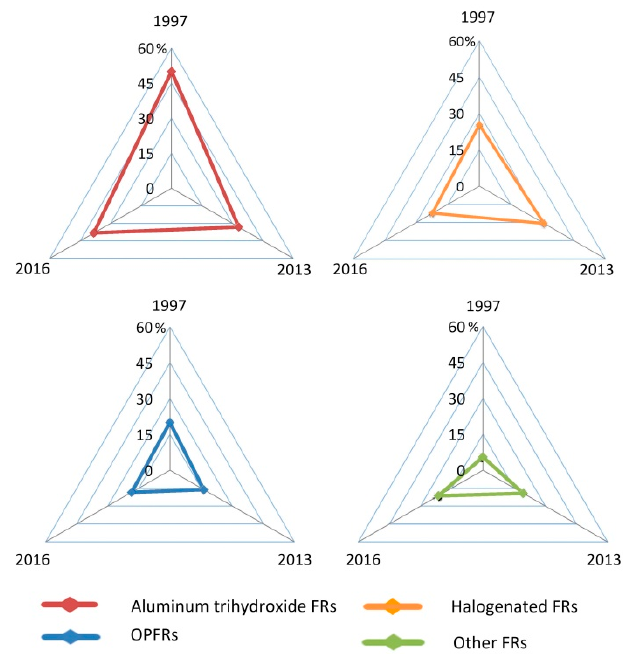
Figure 2. Sketch diagram of consumption of several main flame retardants in different years.